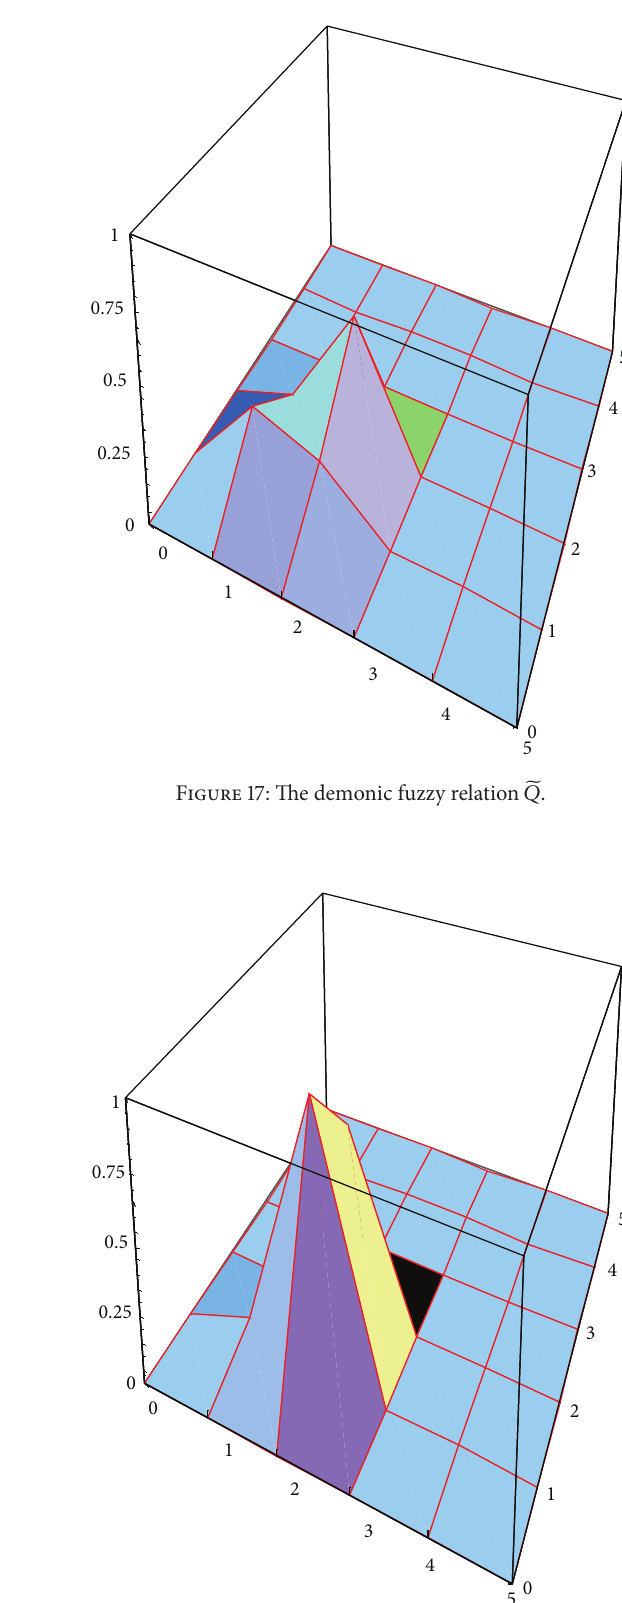
Figure 18: The demonic fuzzy relation